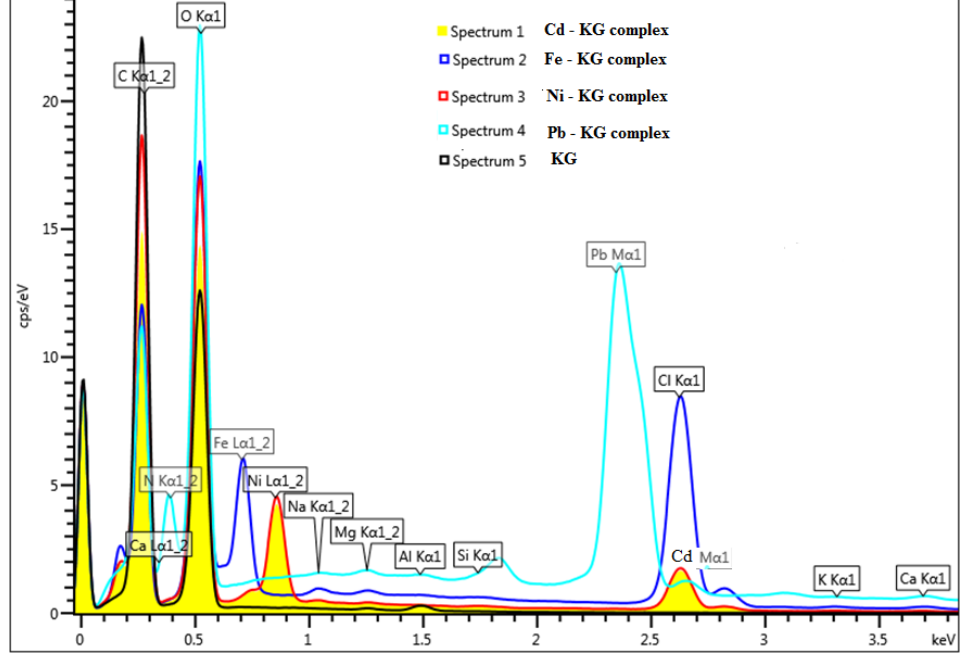
Figure 2. EDAX spectrum of KG before and after metal adsorption (Pb, Ni, Cd and